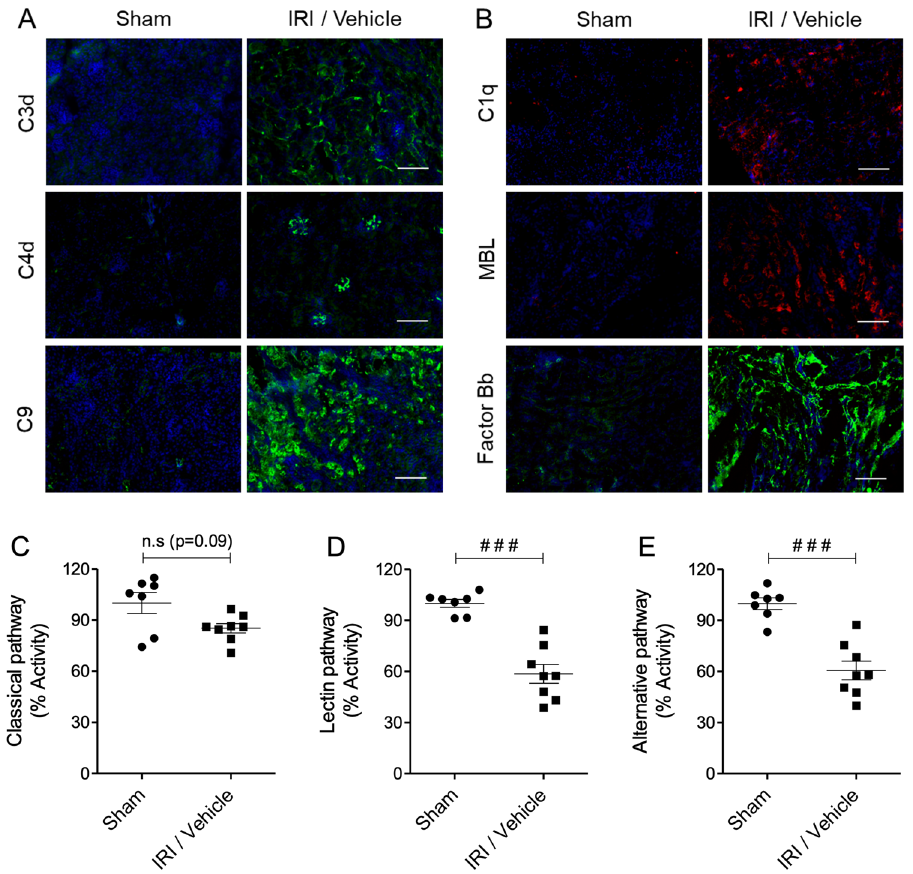
Figure 1. Analysis of complement deposition in renal IRI. Mice were subjected to either right nephrectomy only (sham) or right nephrectomy, 22 min left kidney ischemia and 24 h reperfusion (IRI/vehicle). ( A , B ) Representative images of kidney deposition of ( A ) complement activation markers C3d, C4d and C9, and ( B ) pathway-specific components C1q (classical), MBL (lectin) and factor Bb (alternative) assessed by immunofluorescence staining/confocal microscopy. Scale bar: 130 μm. ( C – E ) Twenty-four hours after reperfusion, serum samples were collected and analysed for complement consumption by measuring ( C ) classical, ( D ) lectin, and ( E ) alternative pathway activities using pathway-specific ELISA kits. Statistical analysis was performed with Mann–Whitney U test (### p < 0.001). The data shown are mean ± SEM, n =